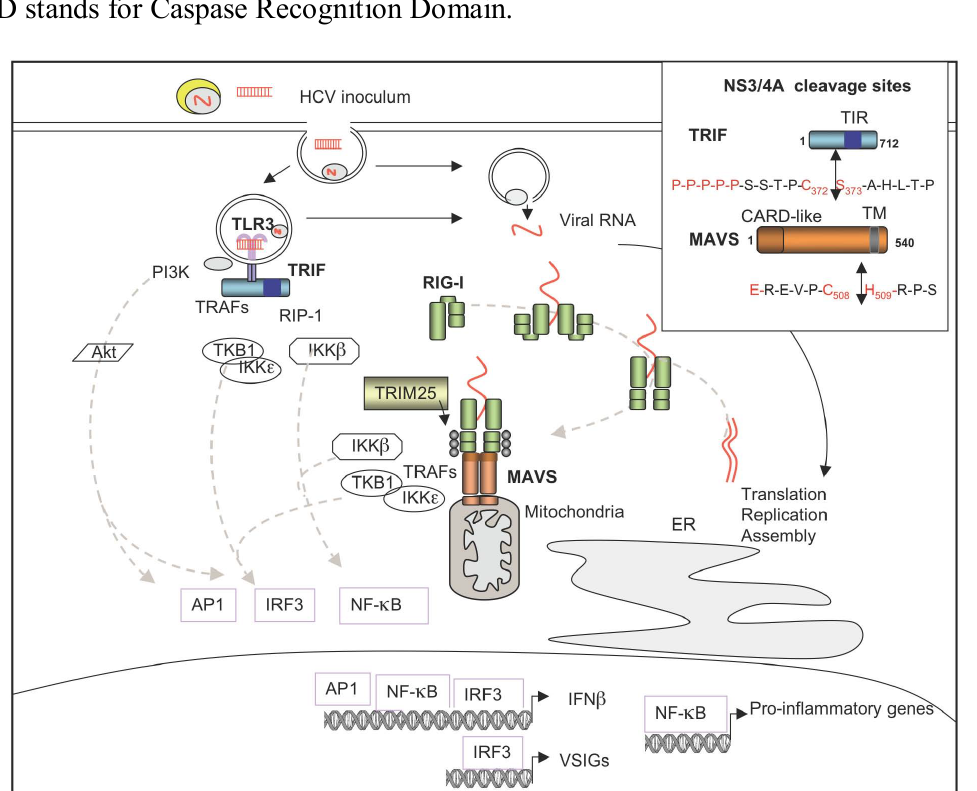
Figure 7. HCV and induction of the innate immune response. HCV activates the innate immune response through the endosomal TLR3 via dsRNA structures (derived from apoptotic of necrotic infected cells) present in the inoculum and through the intracytosolic RNA helicase RIG-I after entry of the viral RNA into the cytosol. Activation through TLR7 is not represented here. Binding of RIG-I to viral dsRNA structures triggers a change in its conformation and its dimerization/multimerization. RIG-I becomes ubiquitined (grey circles) by the E3 ligase TRIM25, which allows its interaction with the mitochondria-bound protein MAVS [157] (MAVS is also known as Cardif [158], VISA [159] and IPS-1 [160]). MAVS recruits different adapters such as members of the TRAF family and the downstream kinases IKK β , TBK1 and IKK ε which activate the transcription factors NF- κ B and IRF3, respectively. In addition, the MAVS pathway can also lead to activation of AP-1 (ATF-2/C-jun) (not represented). Upon binding to dsRNA, TLR3 recruits the intracytosolic adapter TRIF, which itself recruits members of the TRAF family, the adapter RIP-1 (Receptor-Interacting Protein 1) and the NF- κ B- and IRF3-activating kinases. In addition, the TLR3 pathway triggers induction of AP-1 through PI3K/Akt. Combination of the three transcription factors is necessary for efficient induction of IFN β , while IRF3 alone is sufficient for induction of a series of genes, referred to as VISGs (Virus Stress Inducible Genes), which will be later on responsive to IFN. NF- κ B stimulates the transcription of pro-inflammatory genes. Box: The HCV NS3/4A protease has the capacity to abrogate induction of the innate immune response through the cleavage of TRIF, close to its Toll-like/IL-1 Receptor (TIR)-domain and of MAVS, close to its transmembrane domain. The sequence of the cleavage sites is shown. CARD stands for Caspase Recognition